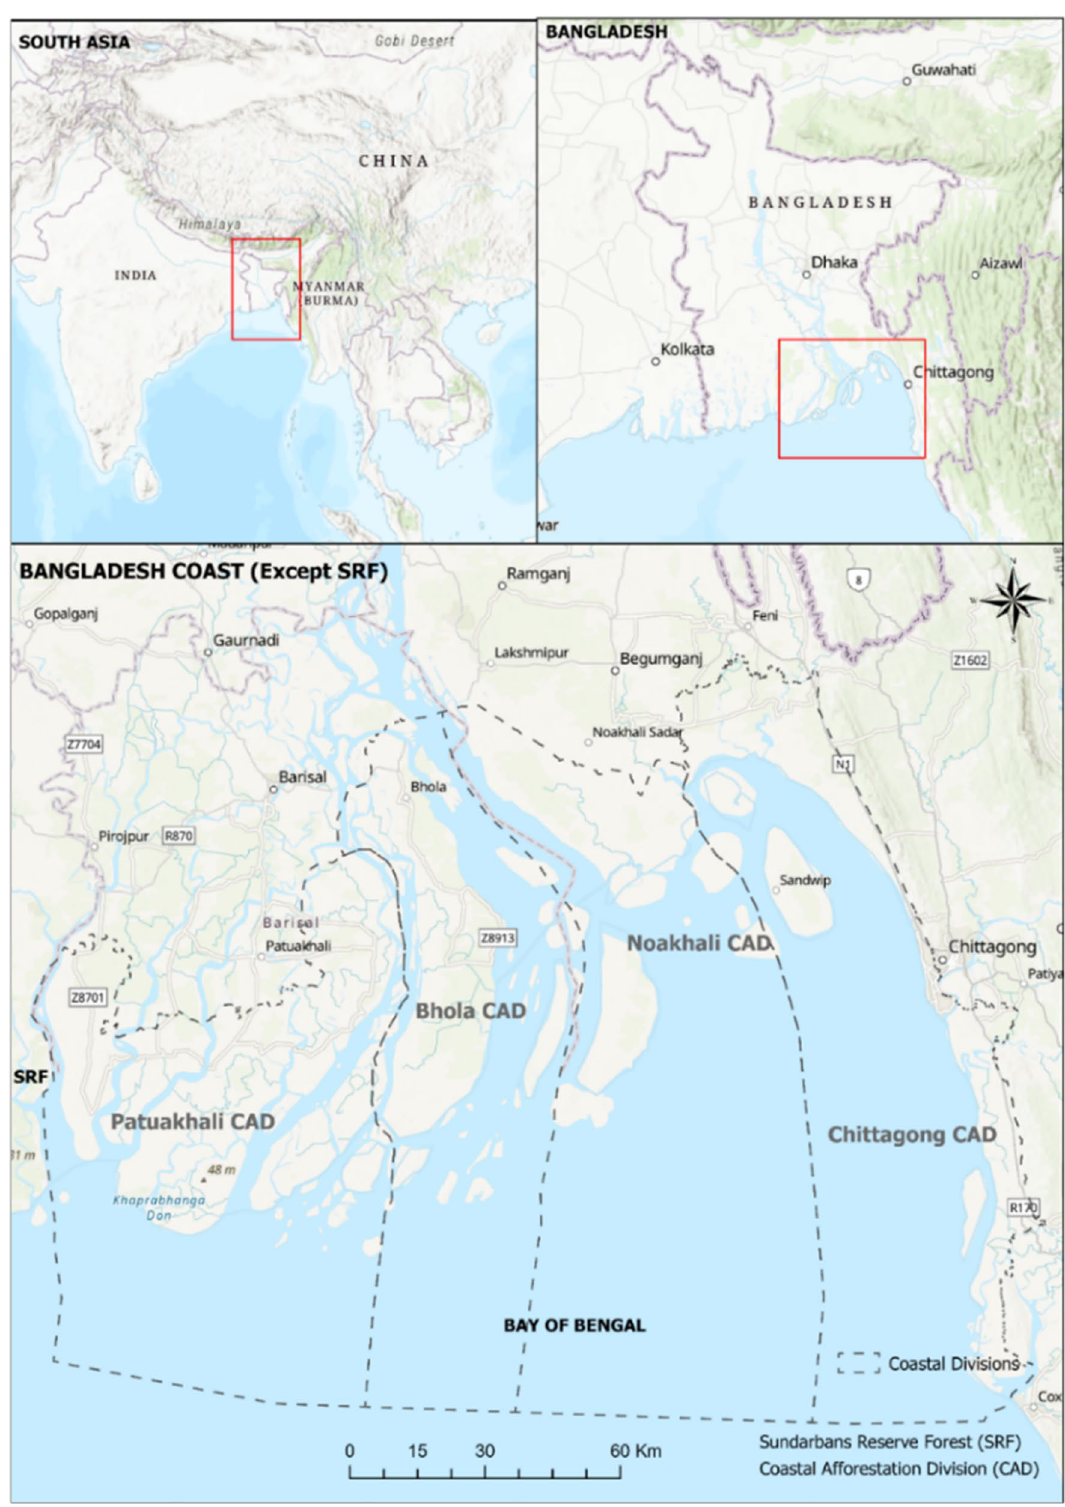
Fig. 1 Coast of Bangladesh except for Sundarbans Reserve Forest (SRF). The grey dashed lines represent four Coastal Afforestation Divisions (CAD) of the country under the jurisdiction of the Bangladesh Forest Department